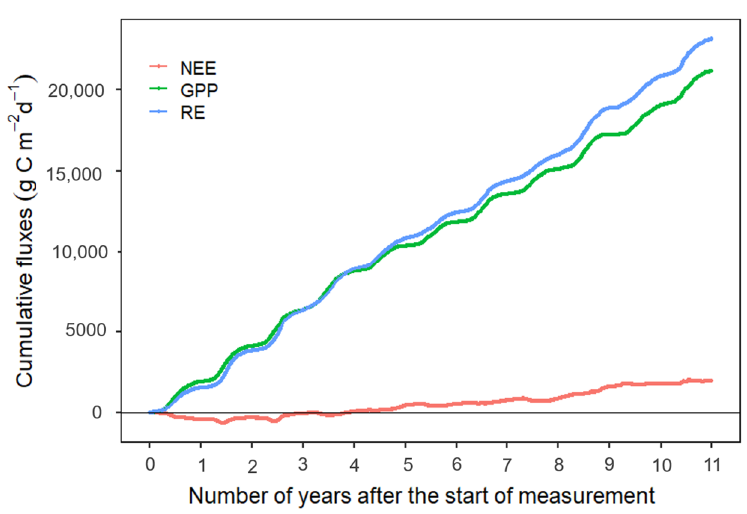
Figure 6. Cumulative gross primary productivity (GPP), ecosystem respiration (RE), and net ecosystem exchange (NEE) for 2009–2019 from flux monitoring of a coastal forested wetland at the Alligator River Natural Wildlife Refuge in Dare County, North Carolina, USA.